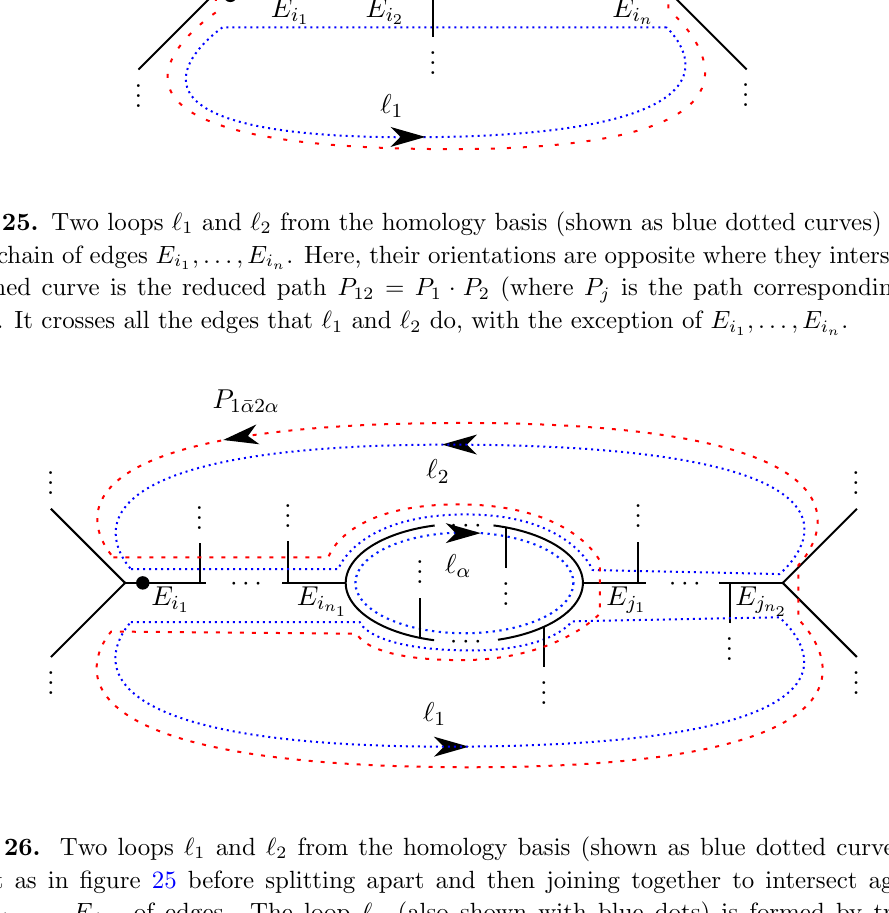
. The red dashed curve is the reduced n 1